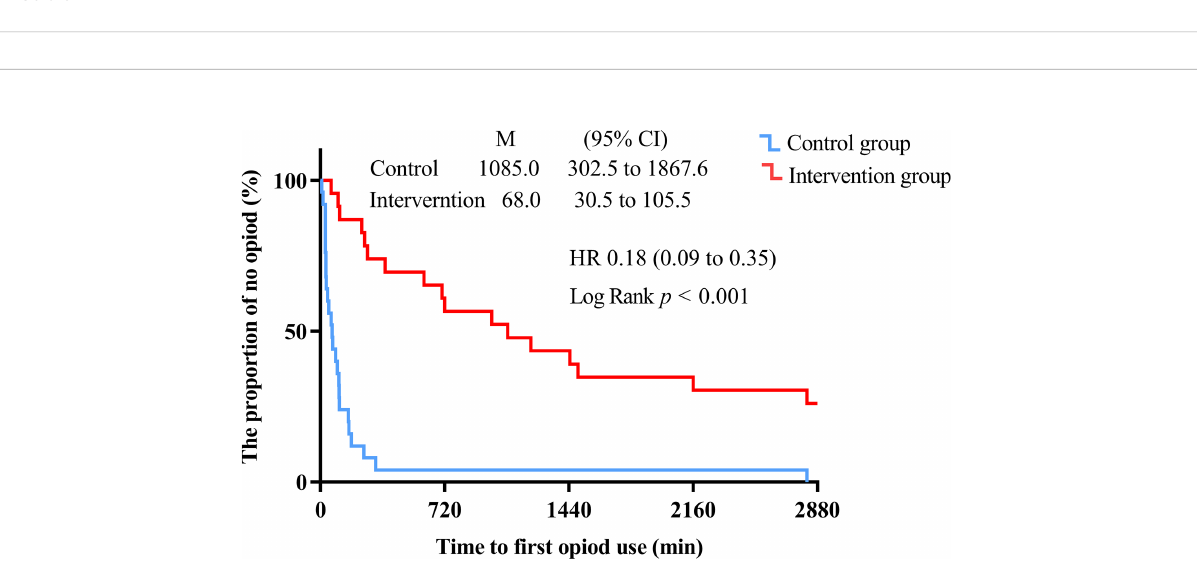
FIGURE 6 Kaplan-Meier survival plot of time to the fi rst compression of the analgesic pump within 48 h after surgery (min). The time to reach PACU is de fi ned as 0 h. Hazard ratios (HR) and 95% CI were estimated using univariate COX